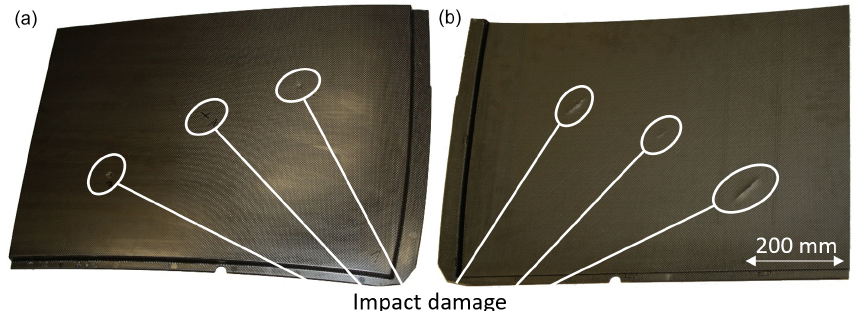
Figure 2. Photographs of the front side with markings (a) and rear view with prominent delaminations (b) of a quartered CFRP roof with impact damage. White circles indicate damage areas.